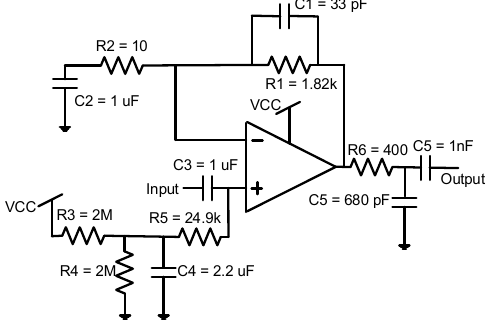
Figure 22. Pre-amplification schematic.